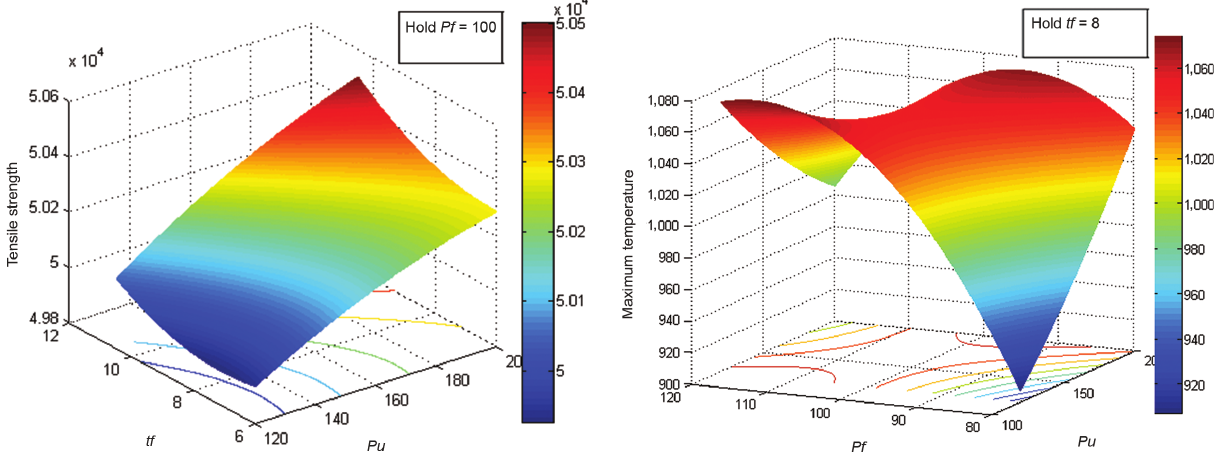
Figure 9: Surface plot of maximum temperature versus Pf and Pu . Figure 8: Surface plot of tensile strength versus tf and Pu